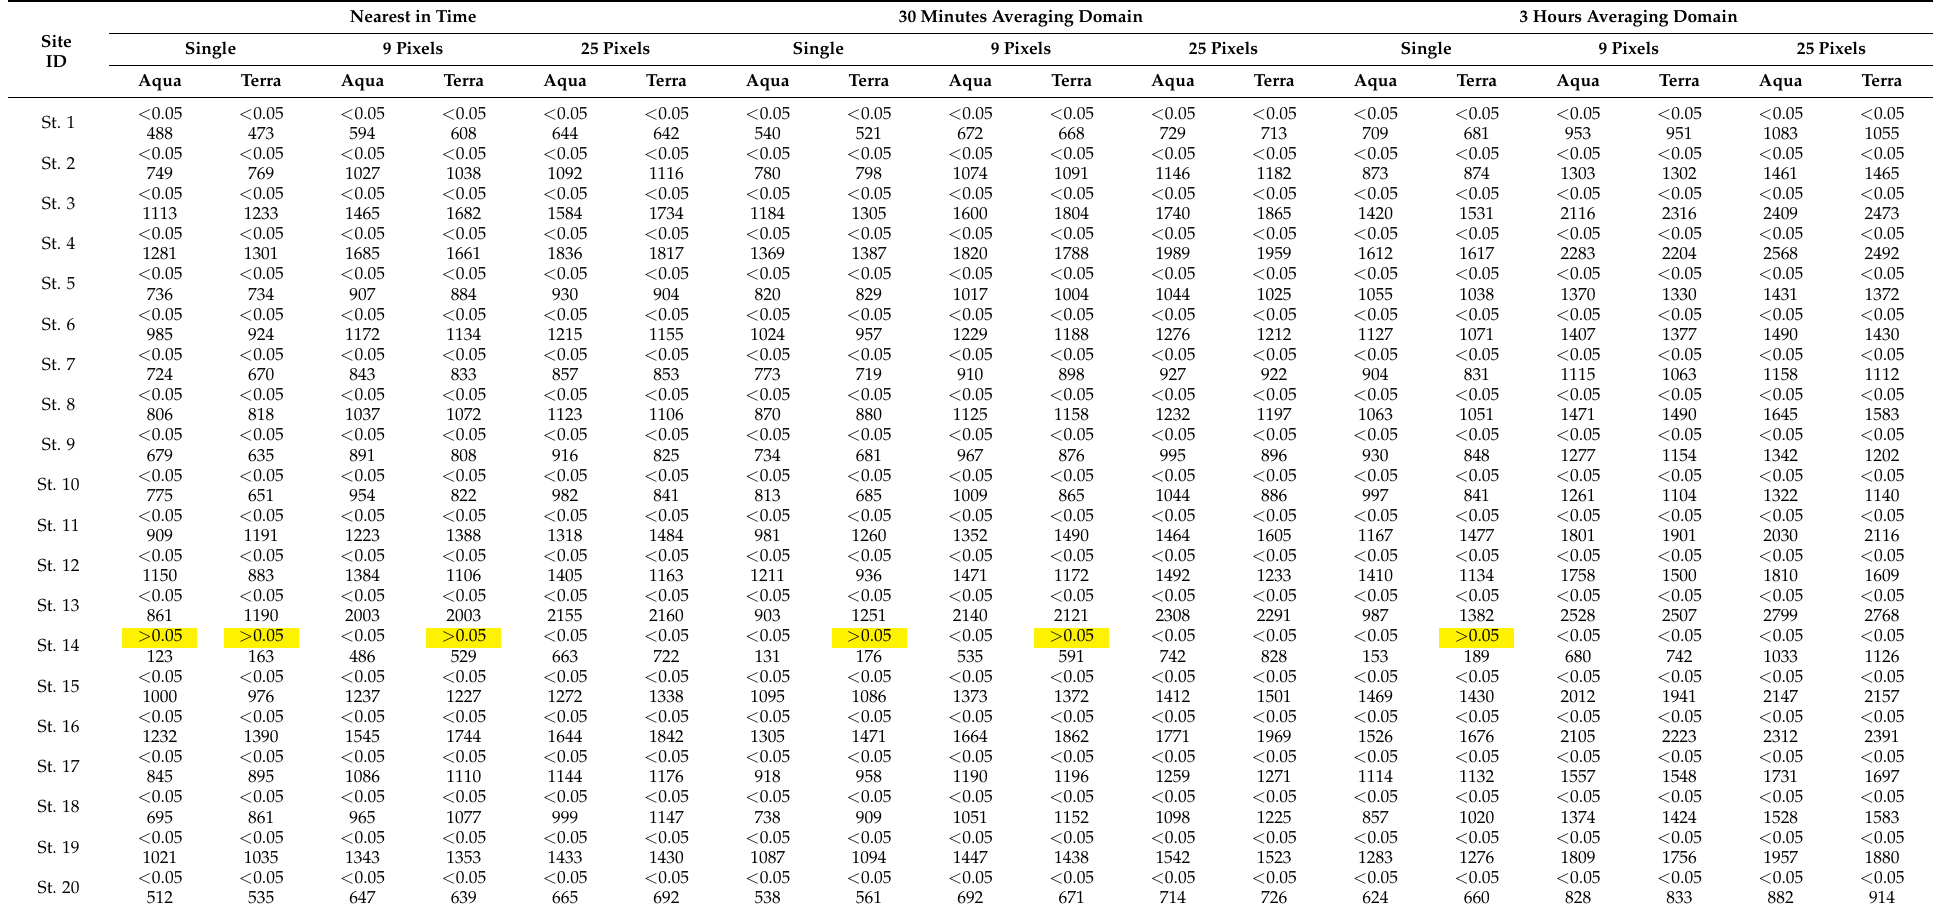
Table A1. p -value and number of matched samples between MODIS DB AOD (Aqua and Terra) and AERONET AOD of 23 sites across western United States at different combinations of temporal and spatial averaging domains. The yellow shaded cells represent a not significant